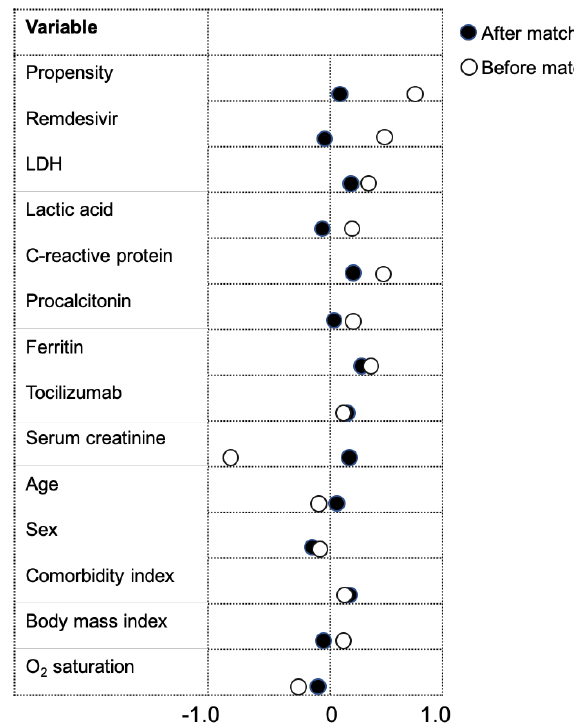
Figure 2. Standardized mean difference in covariates included in propensity score matching. The dot plot provides a graphical display of the standardized mean difference in covariates before and after propensity score matching. After matching the differences between groups were similar or improved. O 2 saturation represents the value at baseline or hospital presentation.